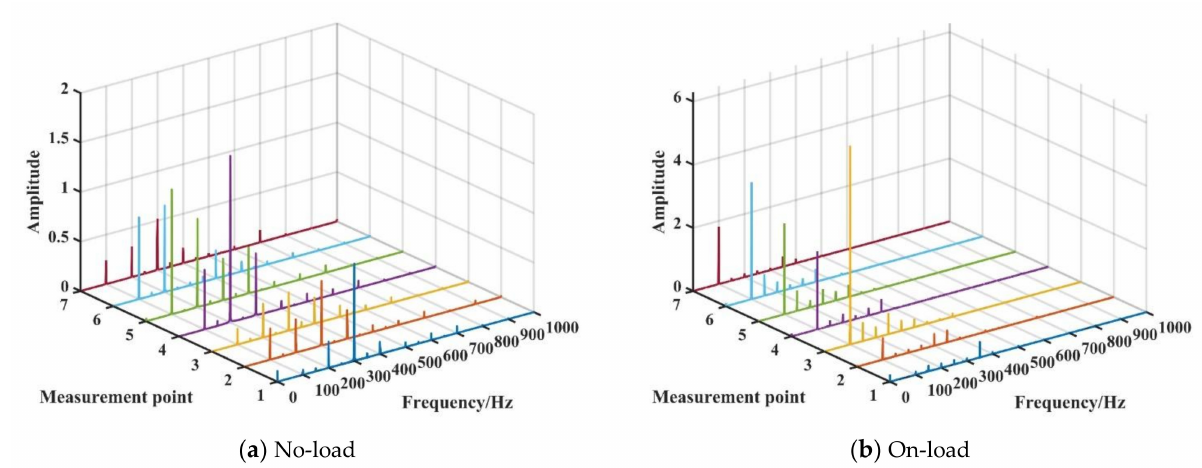
Figure 5. The typical frequency spectrum of the vibration signal of converter